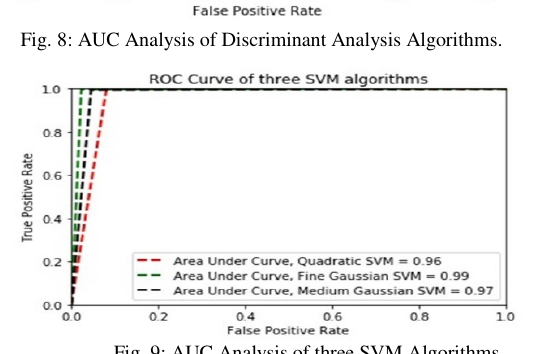
Fig. 8: AUC Analysis of Discriminant Analysis Algorithms.